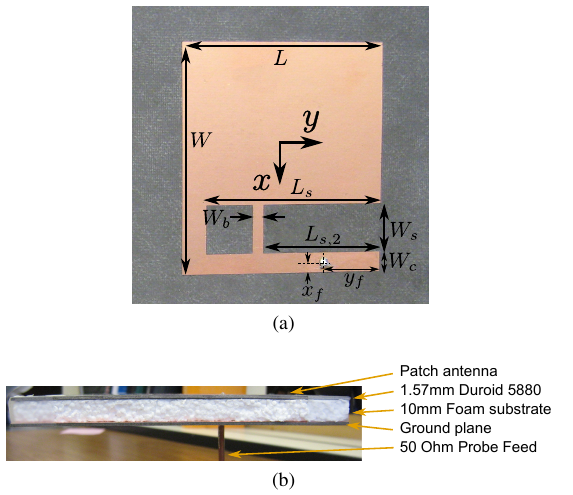
FIGURE 14. Geometry of the CP Half E-shaped patch. (a) Top view of the prototype. (b) Side view showing the layer stackup. Adapted from [21].